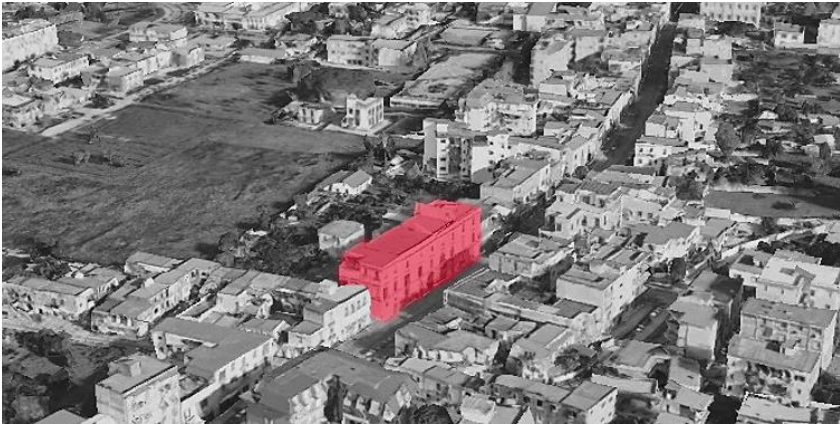
Figure 1. Identification of the case study building.